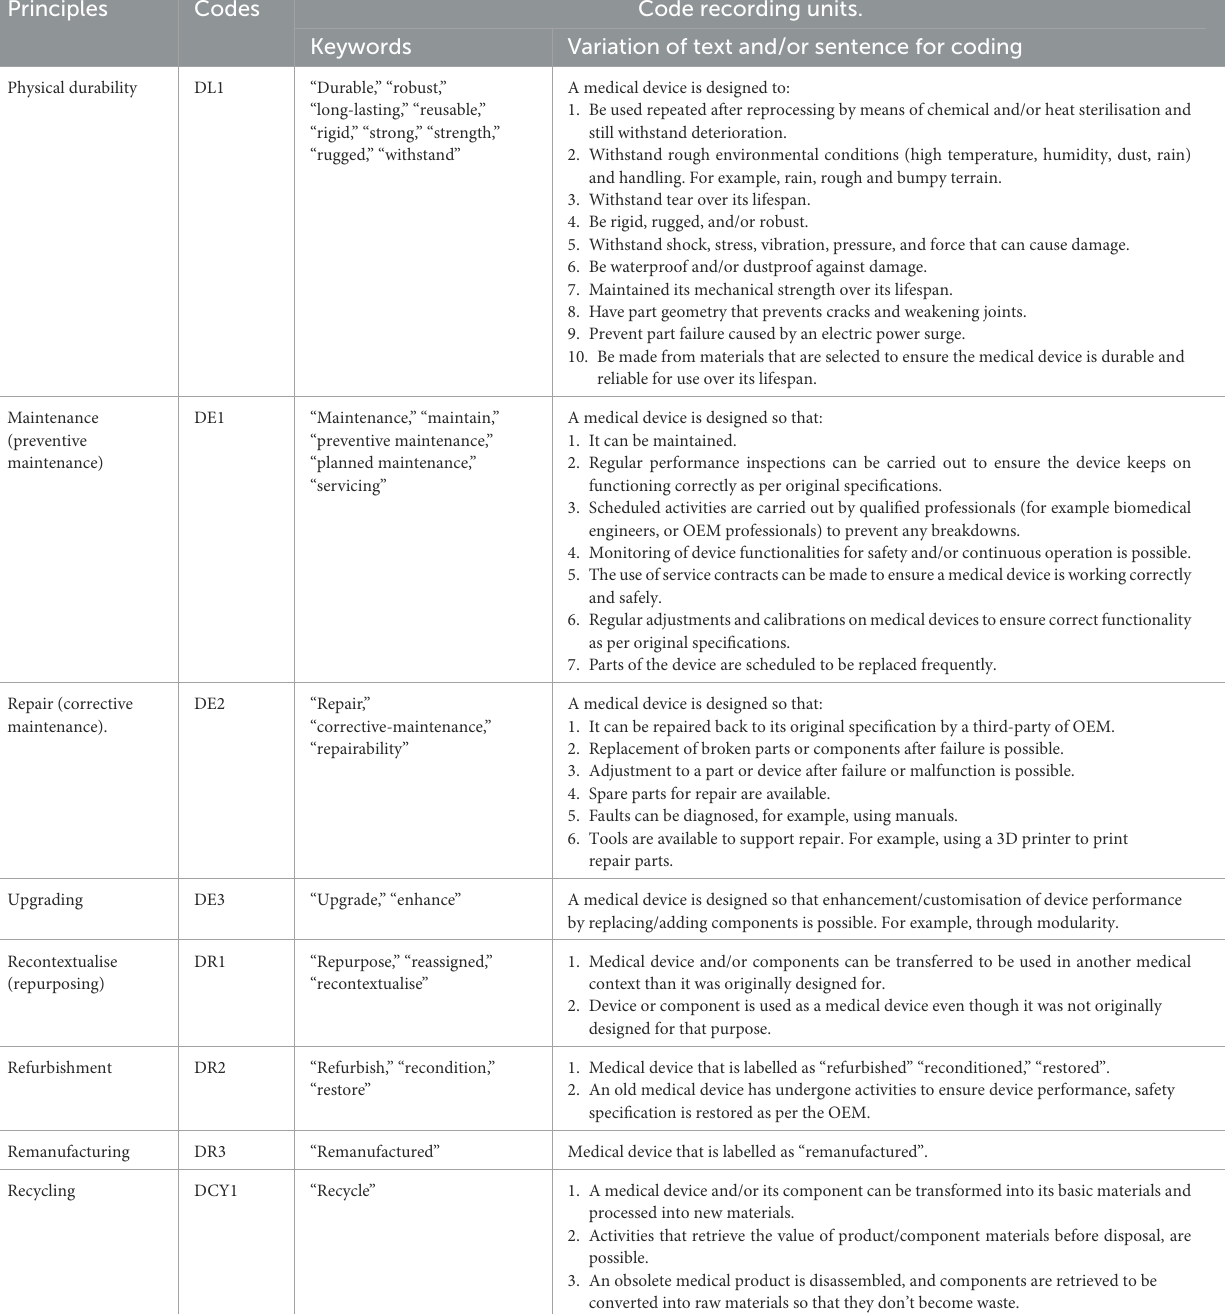
TABLE 2 Circular economy principles, codes and their respective recording units used in the coding process. Principles Codes Code recording